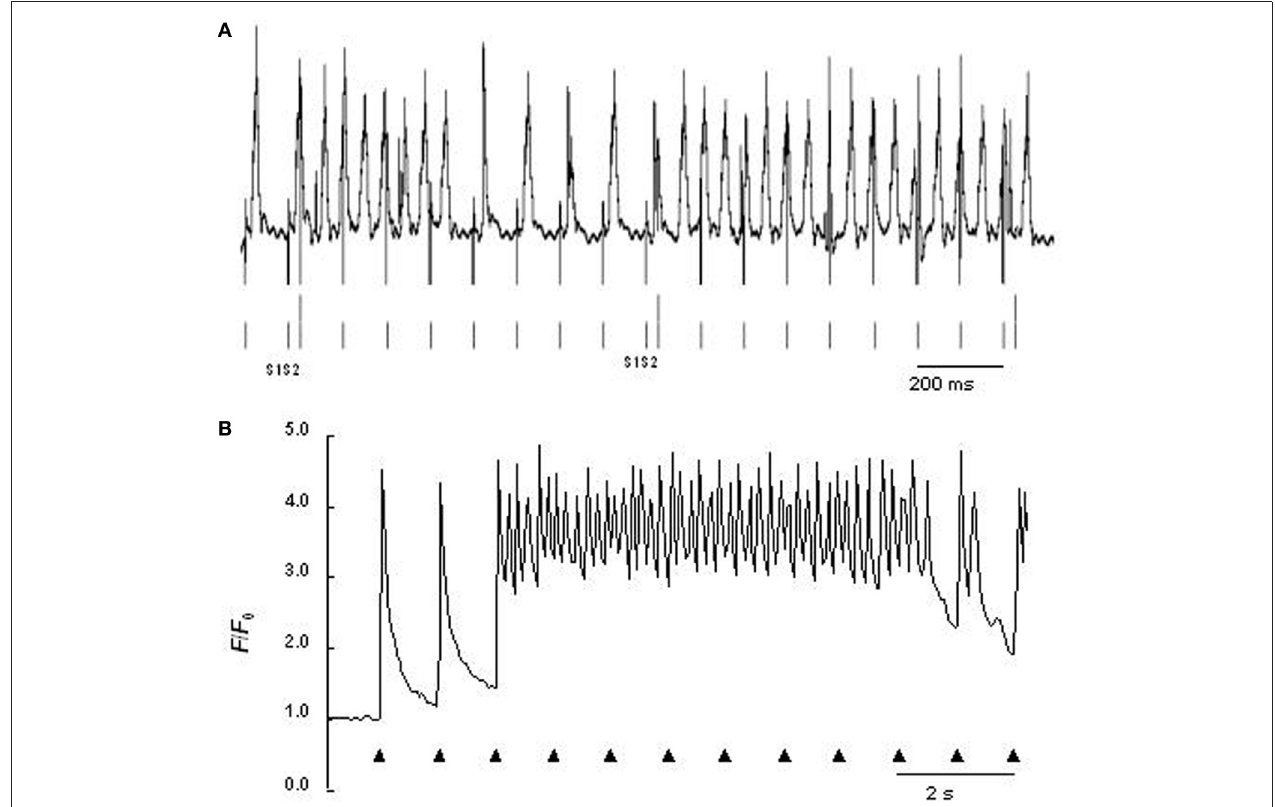
FIGURE 1 | (A) Atrial monophasic action potential recording of arrhythmic events provoked by programmed electrical stimulation involving extrasystolic S2 stimulation (long vertical bars beneath trace) following series of pacing S1 stimuli (short vertical bars beneath trace) from isolated perfused